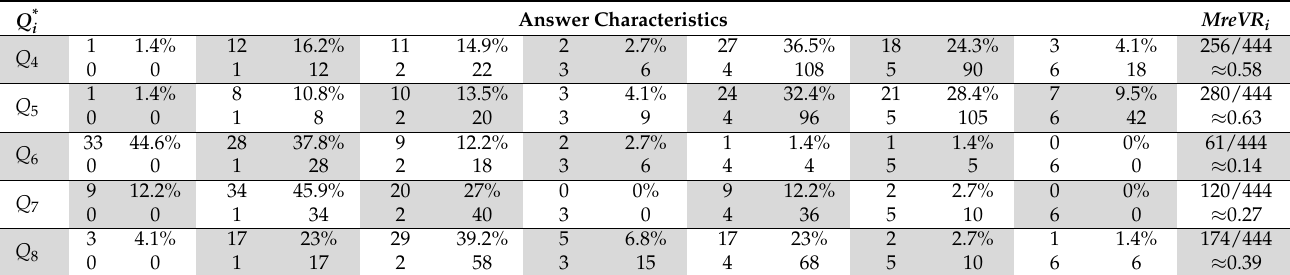
Table 2. Prospects for sustainable marketing mix development.